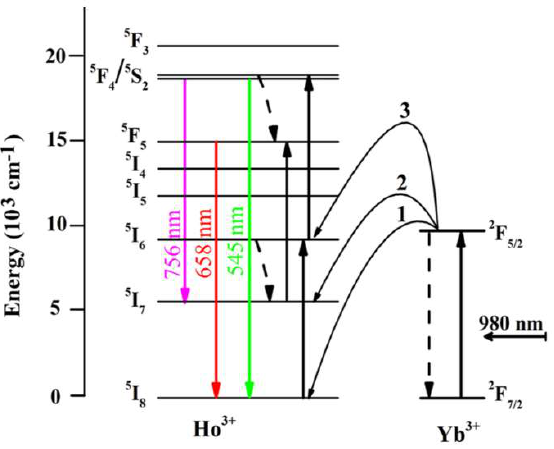
Figure 7. Schematic diagram of energy transfers during the UC process for BHYTO: x Li phos- phors.